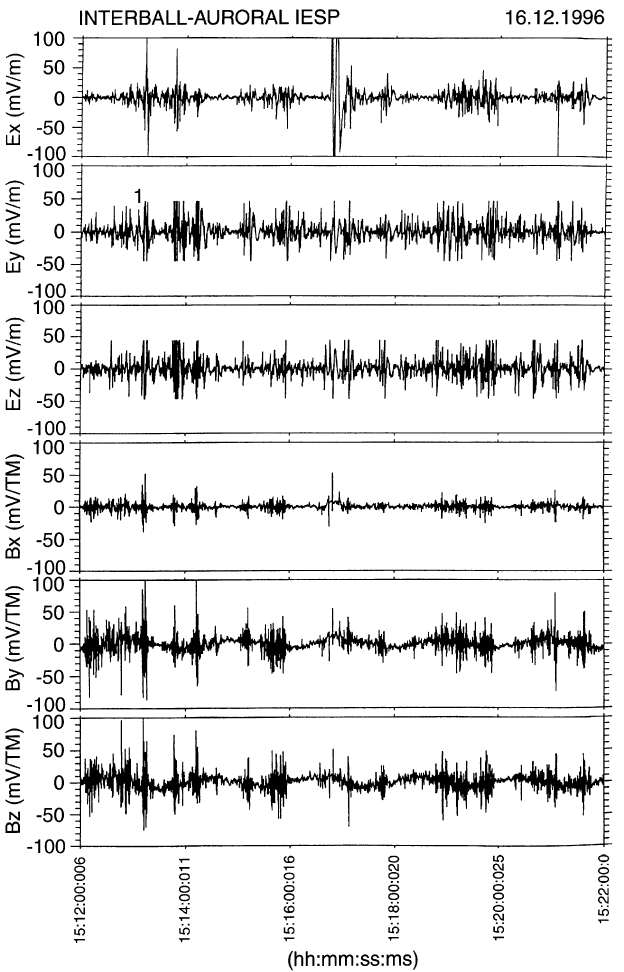
Fig. 5. Same as Fig. 4 with an extended scale. The emission is composed of fluctuations at di(cid:128)erent frequencies in agreement with the Plate